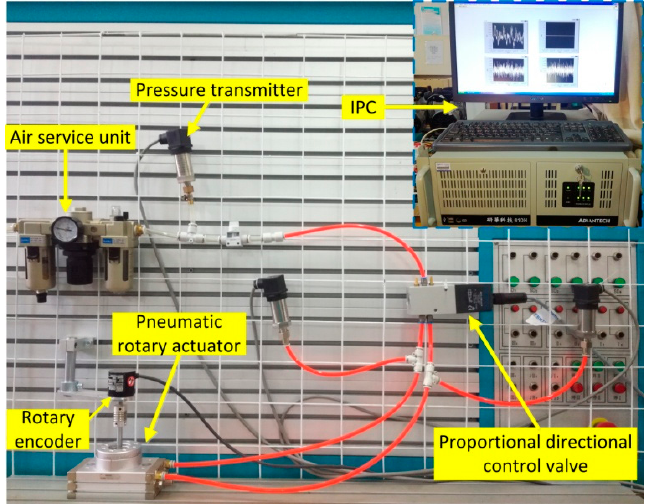
Figure 2 is the experimental platform of the pneumatic rotary actuator position servo system.